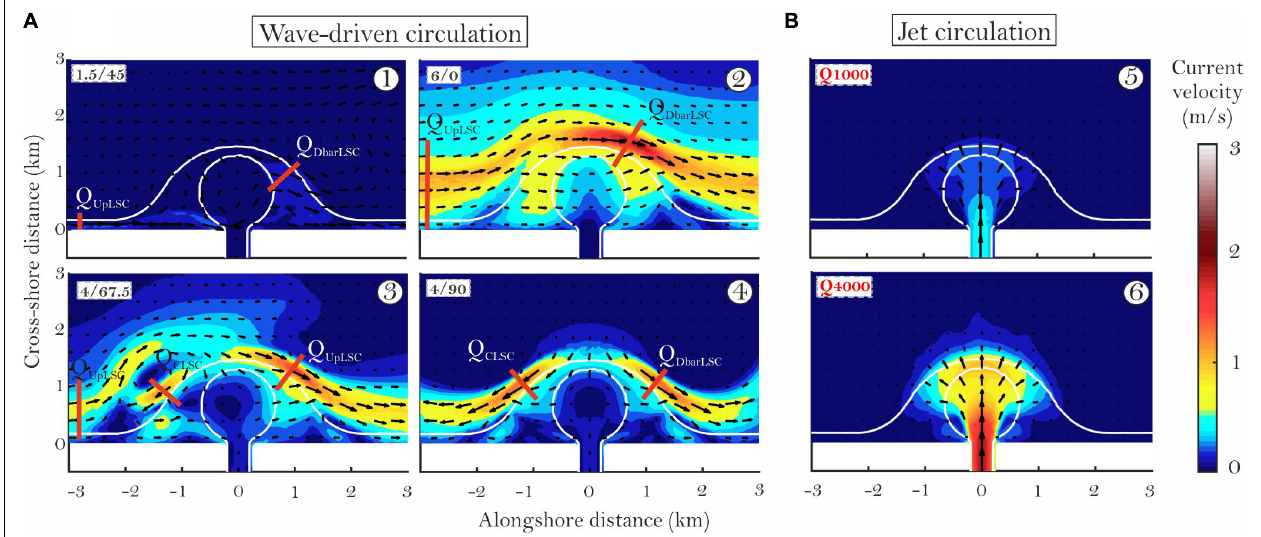
FIGURE 4 | Wave-driven (A) and jet (B) circulation for the Big RMB case. The red lines on the wave-driven circulation types represent the sections through which either discharges ( Q ) of Up LSC , C LSC , or DbarLSC were measured. Conditions for each simulation are shown in the upper left corner of each panel (1.5/45 denotes 1.5 m Hs , 45 ◦ direction; and Q1000 is 1000 m 3 /s discharge). White lines are the –2 m